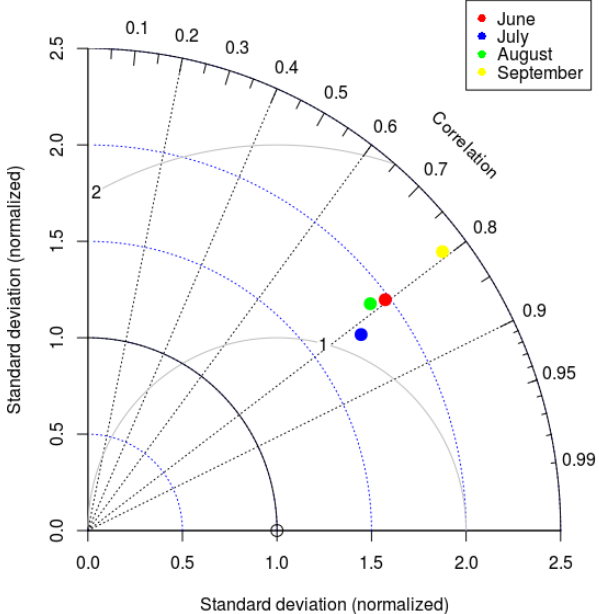
Figure 3. Taylor diagram displaying a statistical comparison be- tween the simulated and remotely sensed tDOC concentrations. The x axis and y axis show the model SD relative to the satellite SD. The open circle on the x axis represents the reference point. The model– satellite correlation is represented in polar coordinates (angle from the x axis). The light grey full lines indicate the RMSE relative to the satellite